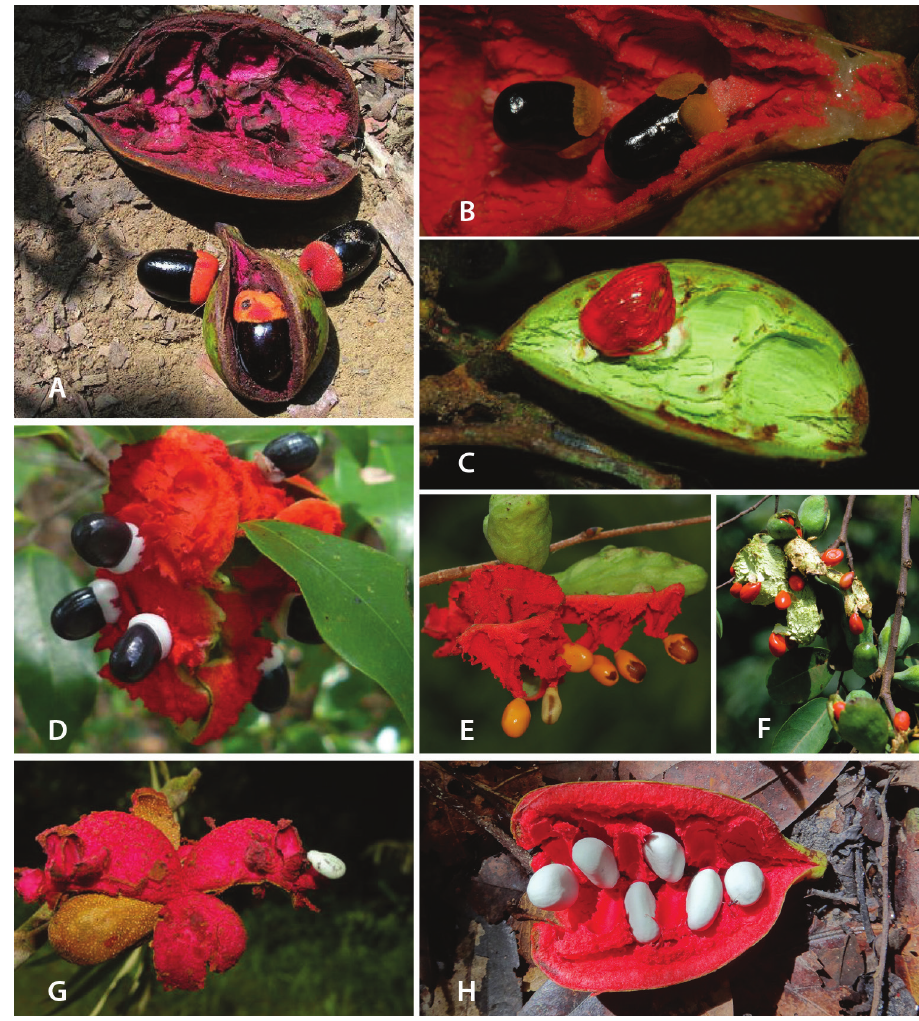
Figure 4. Fruits and seeds of representative Xylopia species. A Xylopia staudtii from Democratic Repub- lic of the Congo B Xylopia aethiopica from Republic of the Congo C Xylopia quintasii from Cameroon D Xylopia tenuipetala from Mozambique E Xylopia collina from Mozambique F Xylopia gracilipes from Mozambique G Xylopia hypolampra from Gabon H Xylopia tanganyikensis from Tanzania. A by Quentin Luke B by David Harris C, G by Thomas L. P. Couvreur D by Jonathan Timberlake E, F by Mervyn Lötter H by Noriko Itoh. C reproduced with permission of Thomas L. P. Couvreur and of the American Society of Plant Taxonomists D reproduced with the permission of Jonathan Timberlake and of the Board of Trustees, Royal Botanic Gardens